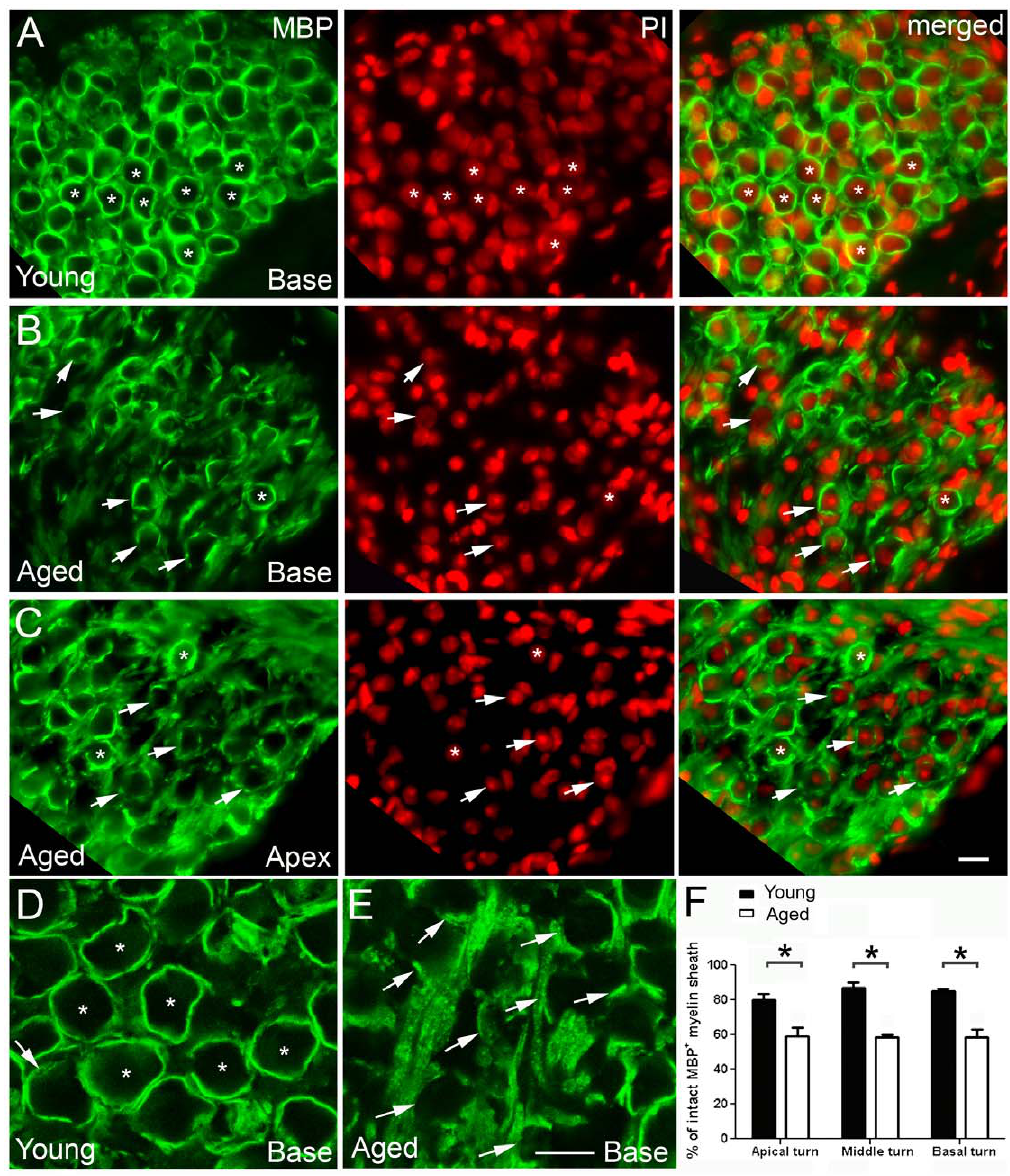
Figure 4. Age-related changes in MBP expression in the CBA/CaJ mouse spiral ganglion. A: MBP + myelin sheaths (green) enclose type I SGNs in Rosenthal’s canal of the basal turn of a one month-old mouse. Intact MBP + myelin sheaths (asterisks) are seen enveloping most neurons. Propidium iodide (PI) nuclear counterstaining (red) reveals nuclear profiles of both SGNs and Schwann cells. SGNs are identifiable by their larger, more weakly stained spherical nuclei whereas the nuclei of Schwann cells are recognized by their irregular shape and more intense staining. B, C: Abnormalities in MBP expression patterns in Rosenthal’s canal of aged mice. Numerous SGNs are enclosed only partially by a MBP + myelin sheath (arrows) and some SGNs appear to lose their MBP + myelin sheath. Asterisks indicate two SGNs with normal-looking MBP + myelin sheaths. D, E: Confocal images of myelin sheaths enveloping neurons from young ( D ) and aged ( E ) mice. Intact MBP + myelin sheaths are indicated by asterisks while broken MBP + myelin sheaths are indicated by white arrows. F: Quantitative analysis of SGNs with intact MBP + myelin sheaths in young and aged mouse ears. The MBP + myelin sheath was considered intact if it enclosed more than 80% of the outline of the perikarya. A significant decline in the percentage of intact MBP + myelin sheath was found in all three cochlear turns in the aged mouse ears compared to young controls (n=5–7 per group; P , 0.01; asterisk). Scale bar, 10 m m in C (applies to A–C ); 10 m m in E (applies to D–E ).